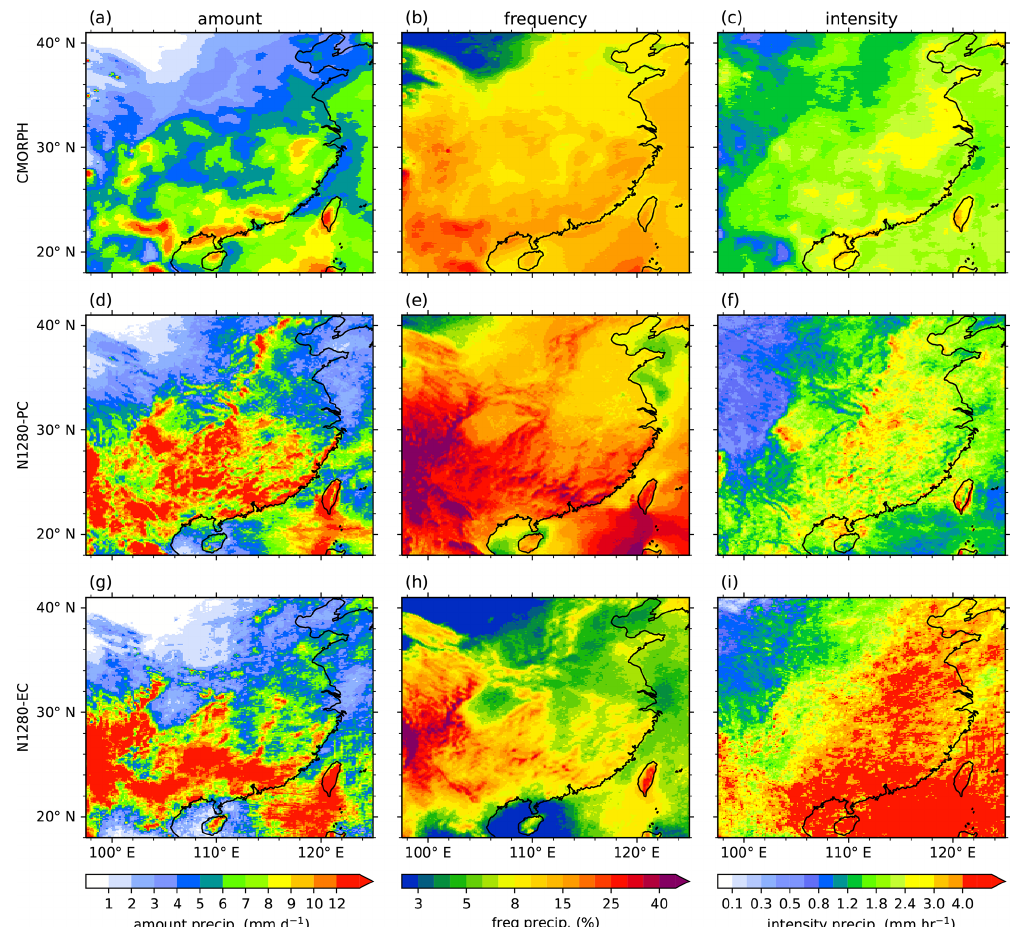
Figure 9. Amount, frequency and intensity of precipitation (columns) over China for CMORPH (a–c) , N1280-PC (d–f) and N1280-EC (g–i)